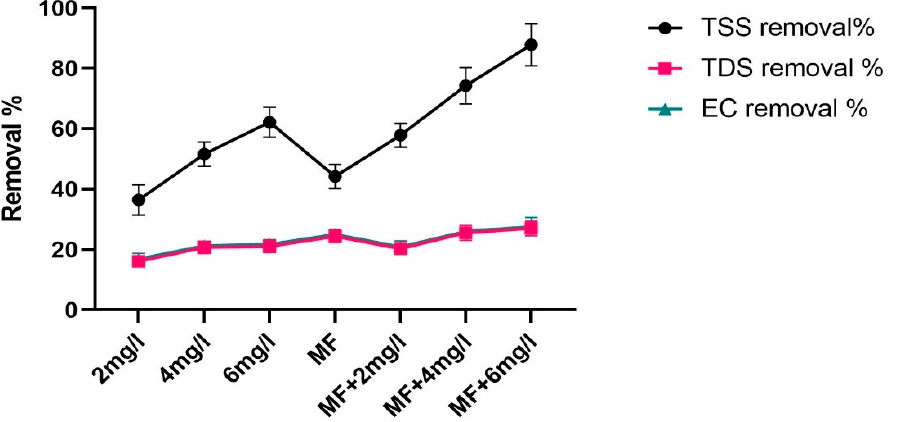
Figure 4. Solids removal % of secondary effluents of SHWW treated by different disinfection meth- ods; (l) 2, 4, and 6 mg/L active chlorine; Disinfection with 12% ( w / v ) commercial NaClO (2) MF: disinfection with magnetic field; and (3) MF + 2 mg/L, MF + 4 mg/L, and MF + 6 mg/L; pretreatment with magnetic field then disinfection with NaClO.